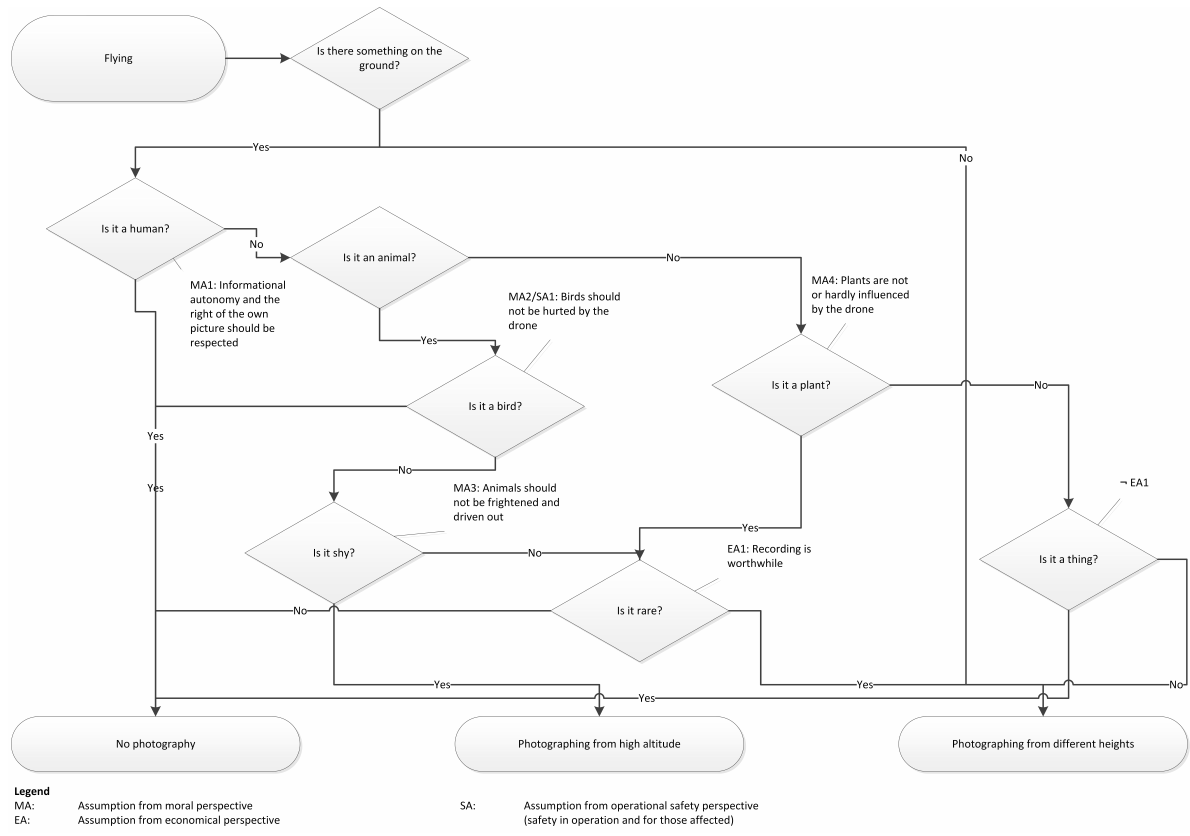
Figure 1: Annotated decision tree for an animal-friendly photo drone according to